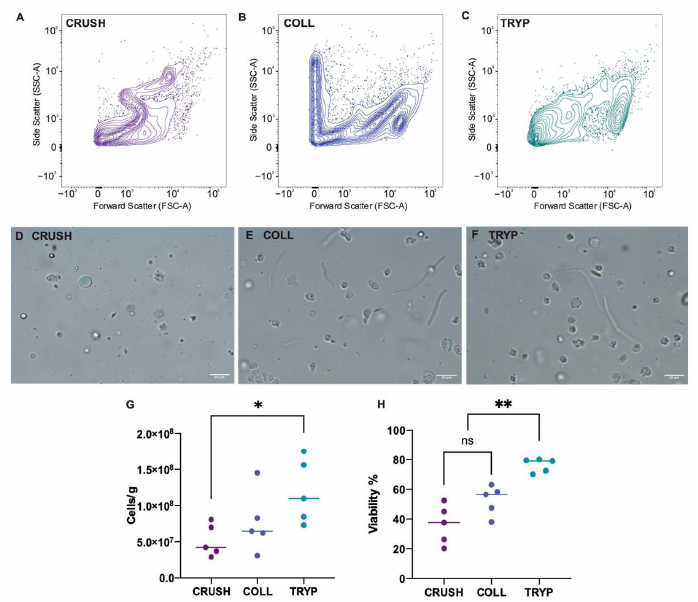
Figure 2. Validation of cell suspension protocol in M. fluviatilis ovarian tissue. The ovary from five ( n = 5) M. fluviatilis were split into three segments and allocated to one of three treatments. Flow cytometry scatter plots for cell suspensions produced using the ( A ) crushing method, ( B ) collagenase digestion and ( C ) trypsin digestion. Images of live cell suspensions in ( D ) crushed, ( E ) collagenase and ( F ) trypsin treated samples. ( G ) The number of cells recovered/gram of tissue was significantly different between crushed and trypsin-treated samples ( p = 0.0364, level of significance indicated by *), but not between crushed and collagenase-treated tissue ( p = 0.5544) nor between collagenase-treated and trypsin-treated tissue ( p = 0.2157; One-way ANOVA with Tukeys post hoc test). ( H ) The viability of cells captured in the 10 µ m and larger region by flow cytometry was highest in trypsin-treated tissue (76.28 ± 4.64%; p < 0.007, level of significance indicated by **) but no difference was observed in cell viability between crushed and collagenase treated samples ( p = 0.0557, non-significance indicated by “ns”; One-way ANOVA with Tukeys post hoc